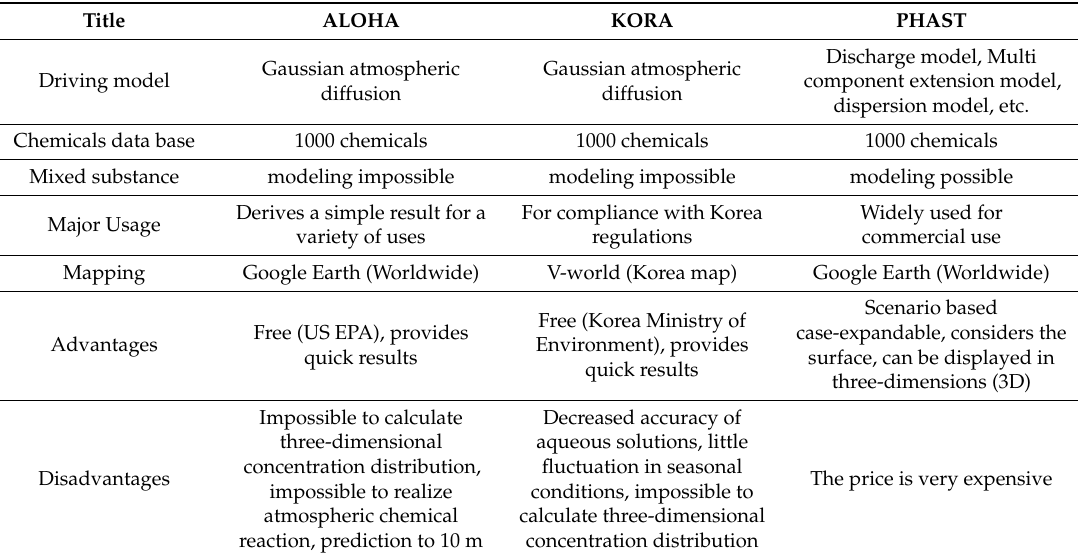
Table 3. Characteristics of three modeling